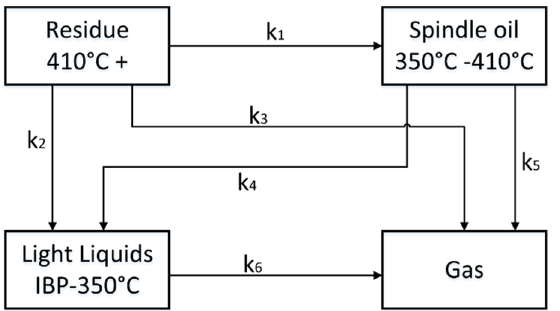
Figure 2. Four-lump system with six monomolecular, irreversible reactions. IBP means initial boiling point higher than 0 °C and Gas is specified by incondensable at 0 °C.